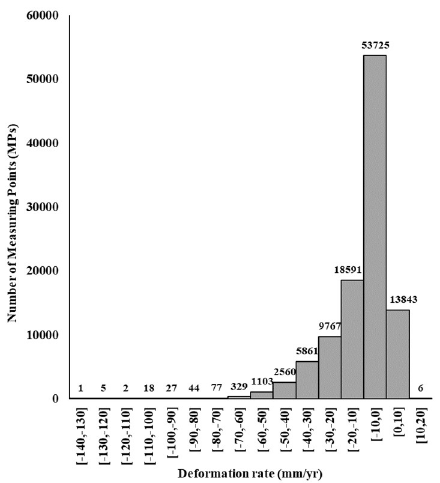
Figure 5. Vertical subsidence rate maps of LJP. ( a ) Result from dataset I; ( b ) result from dataset II. The red star represents the reference point and the white dashed lines show the boundaries of the three zones of analysis.